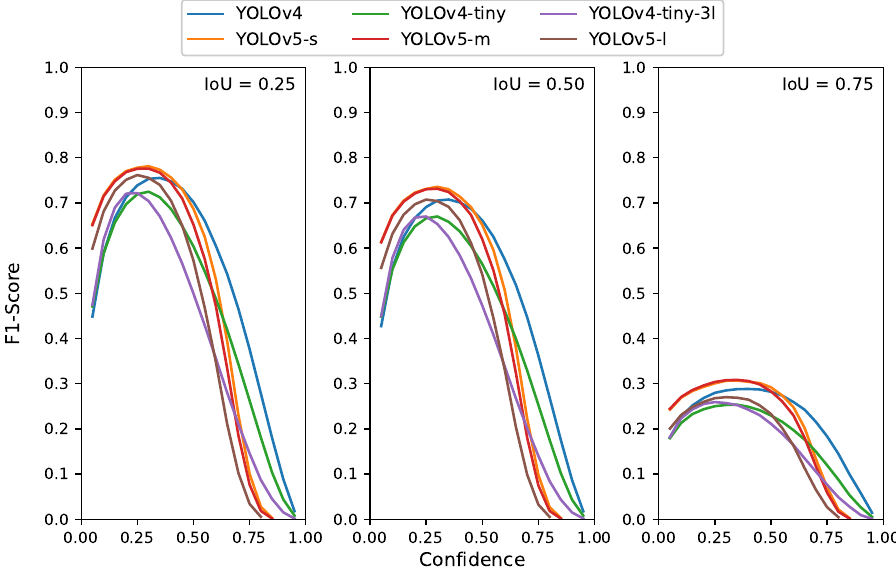
Figure 9. F1-Score vs. Confidence curves at IoU thresholds 0.25, 0.50 and 0.75 for each trained model.